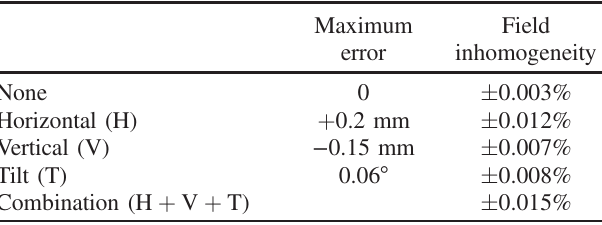
TABLE III. Field inhomogeneity, over a 1 mm radius, for the maximum geometrical errors expected during manufacturing.